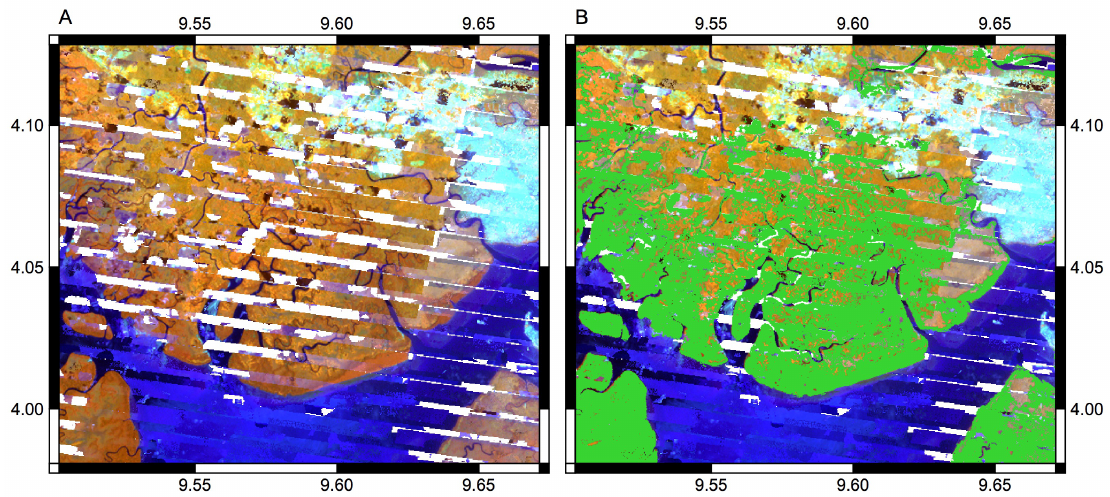
Figure 10. Douala, Cameroon: ( A ) the Landsat Composite; and ( B ) the Landsat composite with the GMW v2.0 baseline overlaid in green, illustrating an area with poor Landsat coverage due to cloud cover, lack of Landsat-5 data and influence of the Landsat-7 SLC-off artefact. The 2010 Landsat composite generated for this study is visualised using the NIR, SWIR and Red wavelength